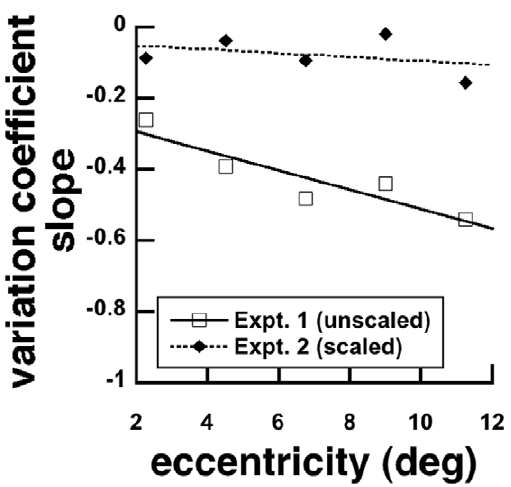
Figure 8. Slopes of the variation coefficients as a function of viewing eccentricity became steeper, approaching 2 0.5, for unscaled stimulus size (Experiment 1), but were generally flat for scaled stimulus size (Experiment